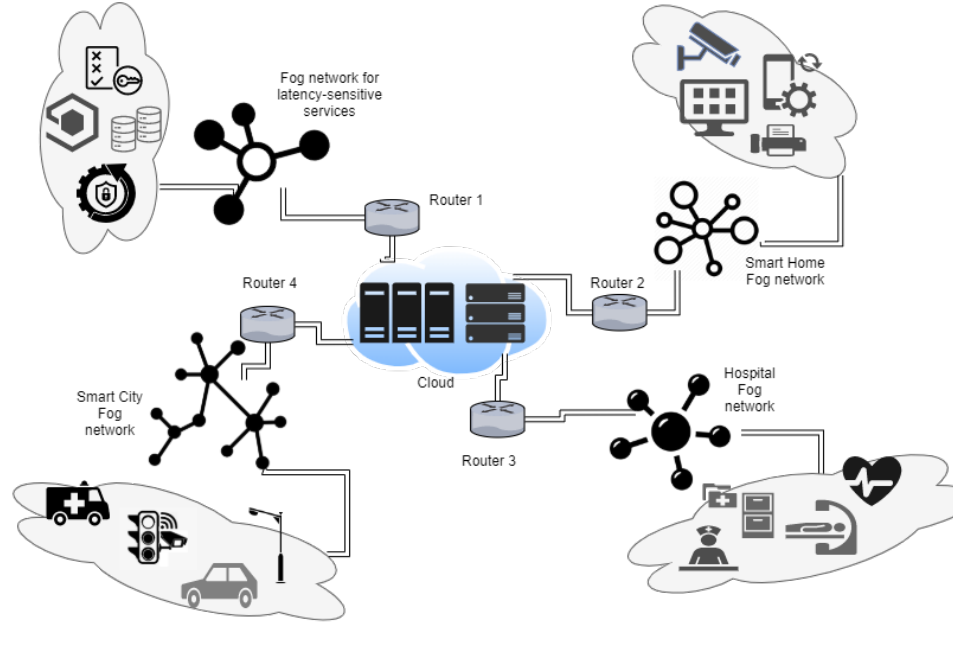
Figure 7. Fog network of heterogeneous